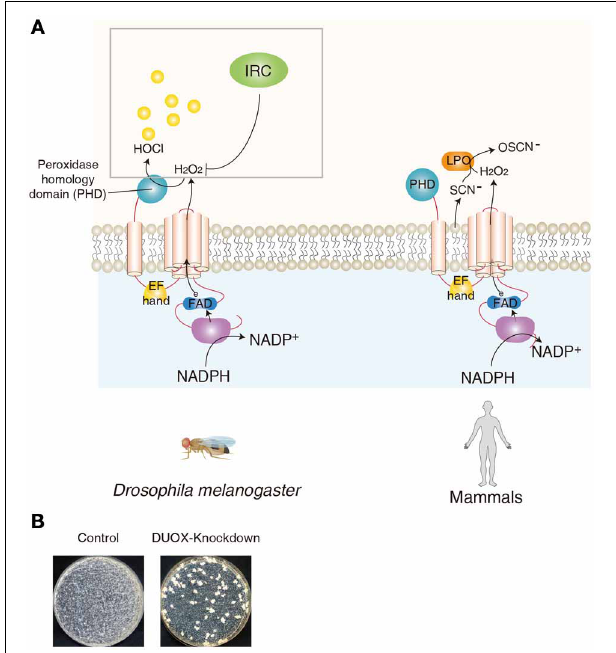
FIGURE 1 | DUOX as a mucosal antimicrobial system in Drosophila and human. (A) Similar domains of DUOX enzymes between Drosophila and human are shown. In Drosophila , peroxidase homology domain of DUOX converts H 2 O 2 into HOCl in the presence of chloride. DUOX-dependent H 2 O 2 molecules are eliminated by immune-regulated catalase (IRC) activity. In human, DUOX-dependent H 2 O 2 is used for the oxidative conversion of SCN − to OSCN − by the enzymatic action of lactoperoxidase in the mucosal fluids. (B) Modification of gut commensal community members in flies carrying reduced DUOX activity. Midgut of control flies and that of DUOX-knockdown flies are dissected and the homogenates of midguts are spread on Mannitol agar plate. Representative images are